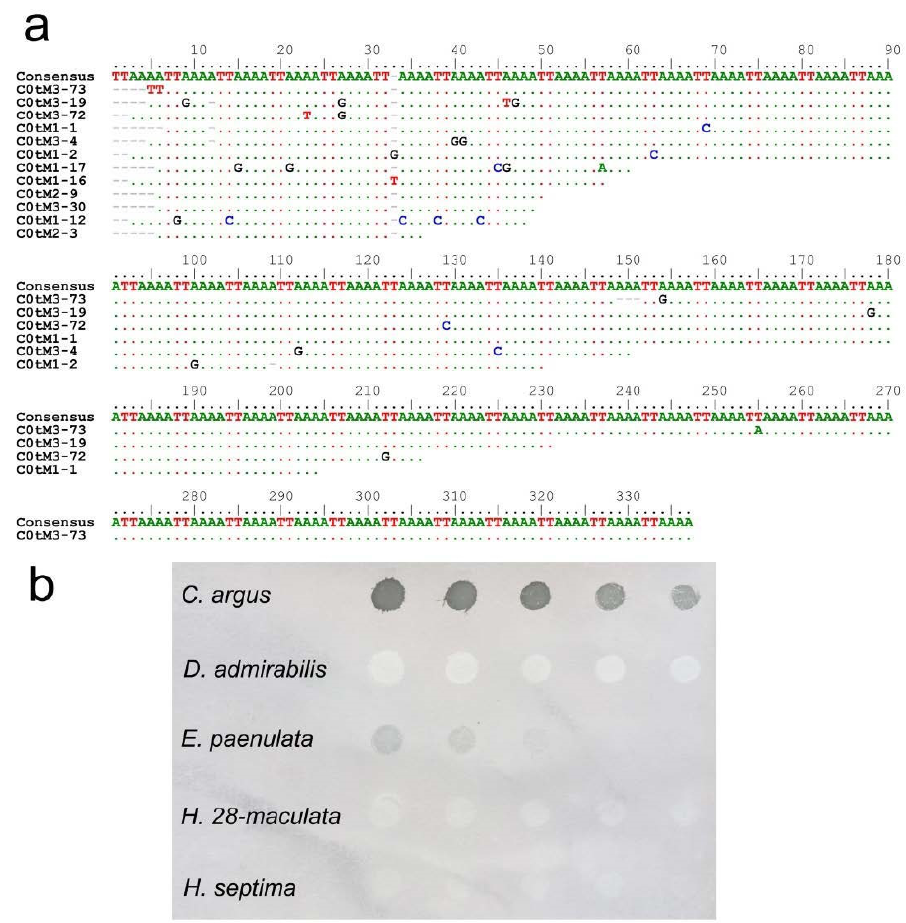
Figure 1. ( a ) Alignment of the sequences obtained by cloning of the C0t-1 DNA, showing that they were basically comprised of the repetition of the sequence TTAAAA. M1, M2 and M3 indicate the DNA sample used for cloning (see details in Materials and methods) ( b ) Dot-blot hybridization on total genomic DNA from Chnootriba argus , Diekeana admirabilis , Epilachna paenulata , Henosepilachna vigintioctomaculata and Henosepilachna septima . Different amount of genomic DNA (1 μ g to 62.5 ng) were loaded into nylon membrane and hybridized with the TTAAAA repeat.